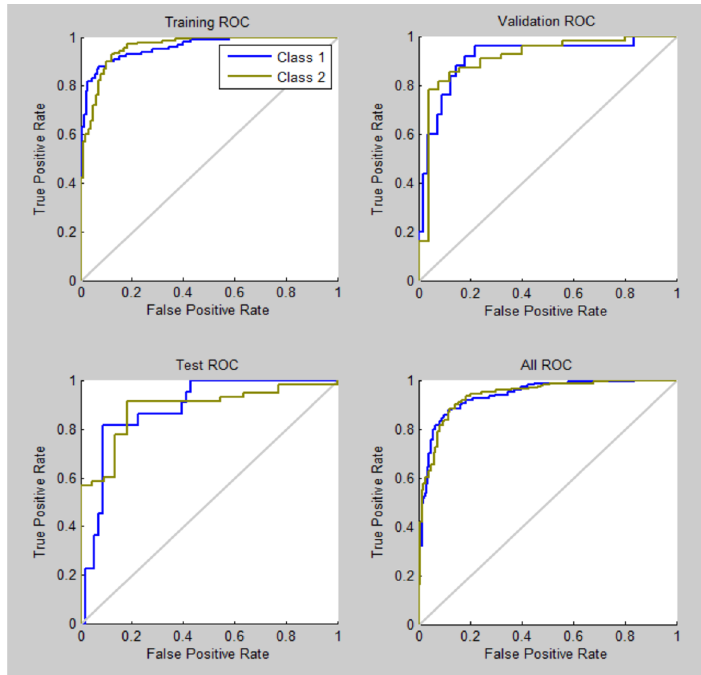
Figure 9. ROC Curves showing the performance of the classificatory when applied to RapidEye images. Class 1 indicates infected blocks, while class 2 indicates blocks where the pest has not been detected.